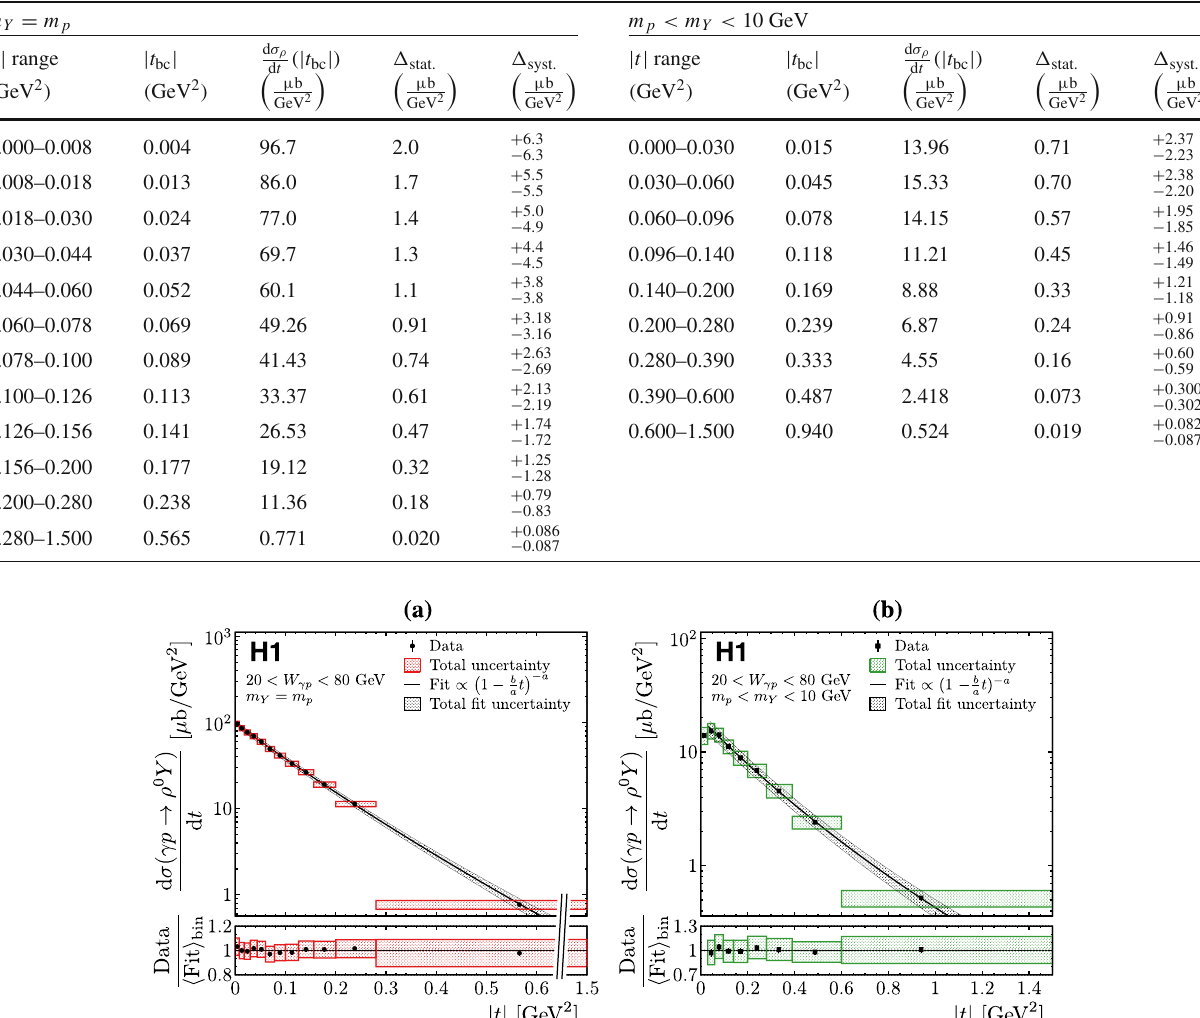
Table10 Elastic( m Y = m p )andproton-dissociative( m p < m Y < 10GeV) differential ρ 0 meson photoproduction cross sections d σ(γ p → ρ 0 Y )/ d t in bins of t . The cross sections are obtained by analysing the π + π − photoproduction cross sections given in Tables 20 and 21 with the fit model defined in Eq. (18). The t bin centres t bc are